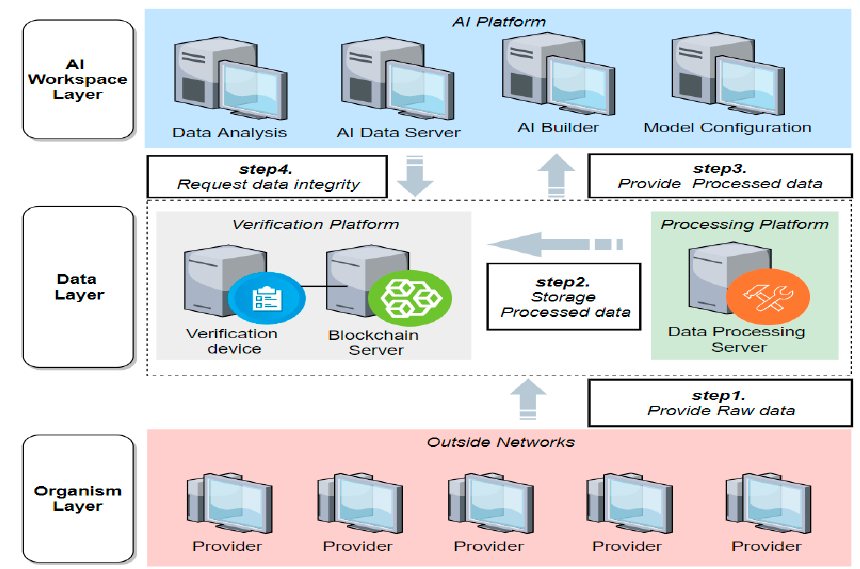
Figure 4. AI environment structure for verification.